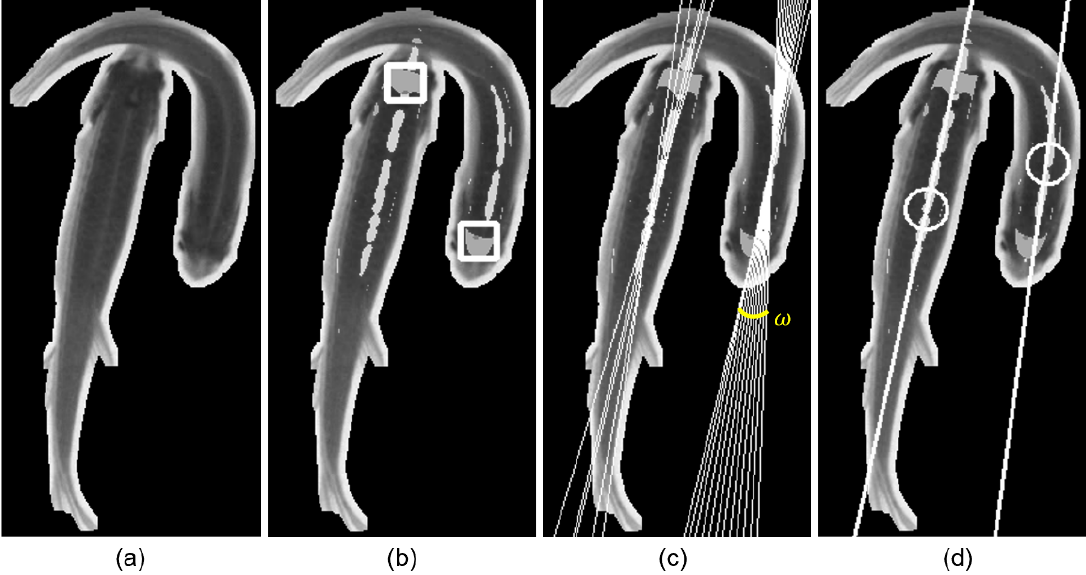
Figure 4. ( a ) Blob image, ( b ) head, ( c ) motion state, ( d ) body point.